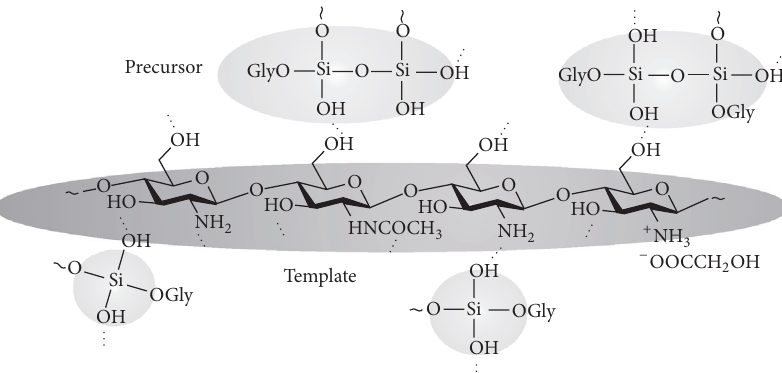
Figure 5: A hypothesized scheme of the intermolecular interactions in the chitosan-silicon-containing hydrogel based on CS-GA and Si(OGly) 4 ⋅ 2Gly \X